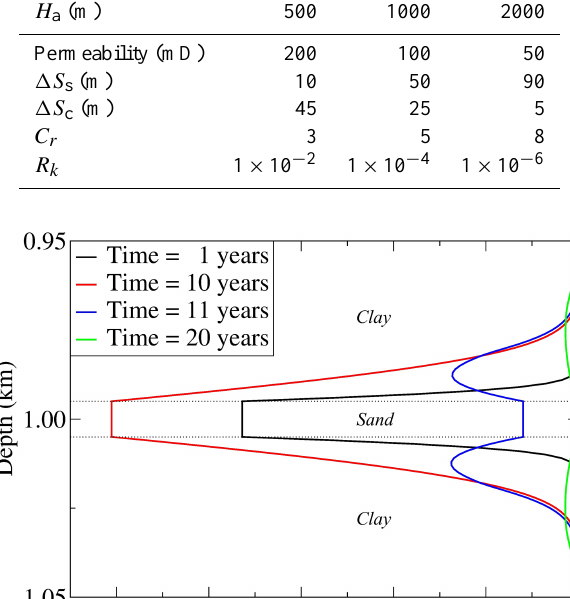
Table 1. The values of the four parameters used in the simulations: depth H a and permeability of the producing aquifer, thickness of the sandy ( (cid:49)S s ) and clayey ( (cid:49)S c ) layer, ratio between the oedometric compressibility in first and second loading cycle and ratio between the sandy and the clayey hydraulic conductivity.